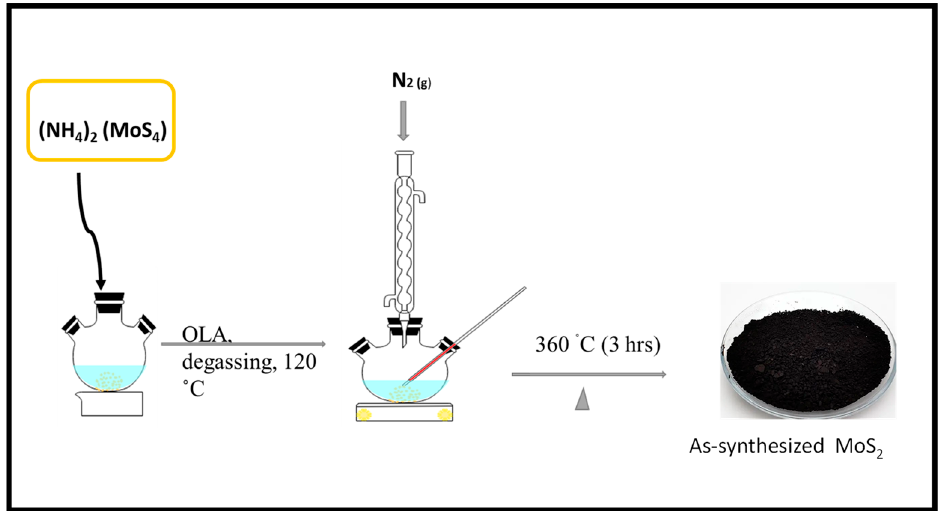
Figure 8. Schematic illustration of MoS 2 synthesis by the colloidal method.